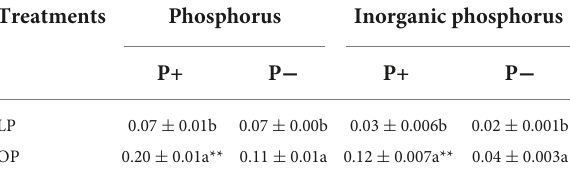
TABLE 1 Phosphorus and inorganic phosphorus concentrations in the roots of dual-root soybean (%). Treatments